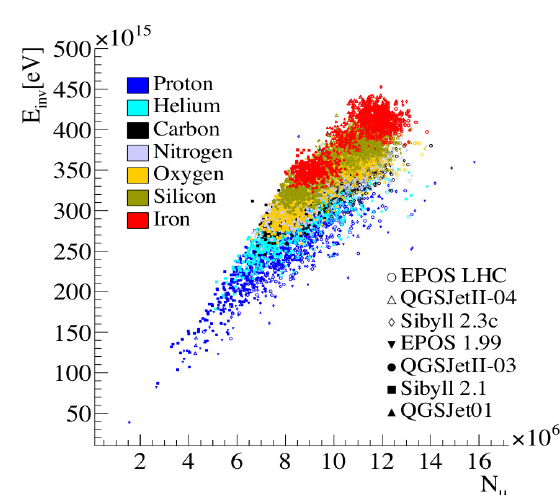
Figure 2. Correlation between E inv and the number of muons reaching ground with energy greater than 100 MeV for di ff erent hadronic interaction models and primaries simulated with energy of 3 × 10 18 eV arriving at 60 ◦ at the altitude of the